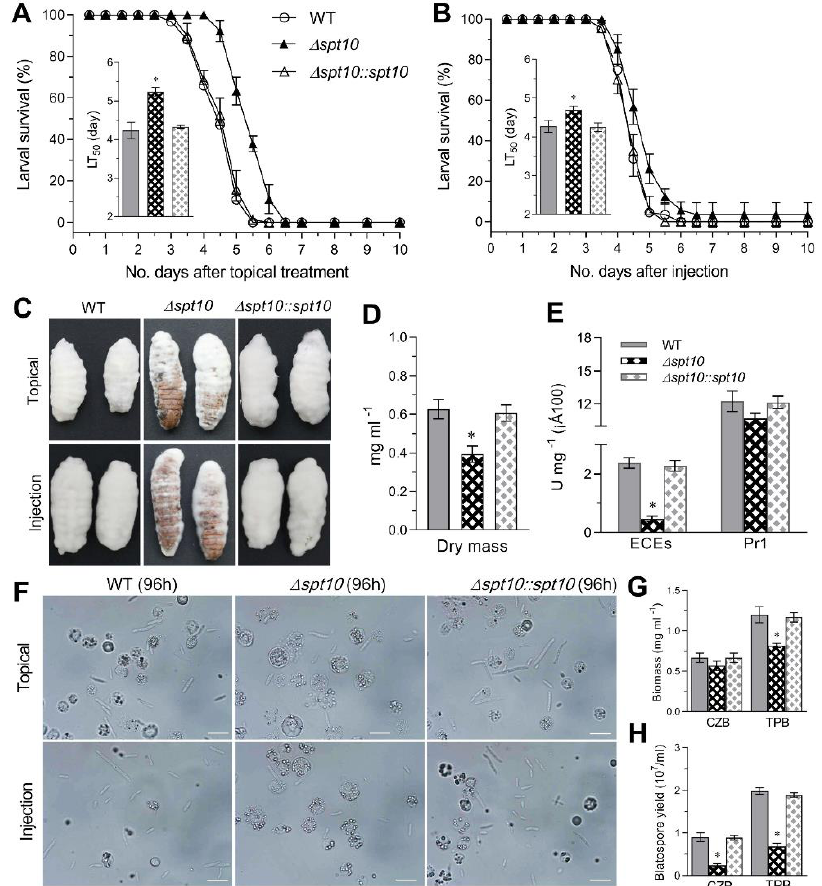
Figure 5. Impact of Spt10 deletion on virulence and virulence-related properties in B. bassiana . ( A , B ) Survival trends and LT 50 estimates of G. mellonella larvae after topical application of a 10 7 conidia ml –1 suspension for normal cuticle infection and intrahemocoel injection of 500 conidia per larva for cuticle bypassing infection, respectively. ( C ) Images for fungal outgrowths on the surfaces of cadavers 4 days post-death. ( D , E ) Biomass levels and total activities of extracellular enzymes (ECEs) and Pr1 proteases quantified from the 3-day-old cultures in CZB-BSA, which contained 0.5% BSA as the sole nitrogen source for enzyme induction and 10 5 conidia ml –1 for culture initiation. ( F ) Microscopic images (scale: 20 μm) for the hyphal bodies formed in the hemolymph samples of G. mellonella larvae 72 h post-topical treatment or post-injection. Spherical or subspherical cells represent host hemocytes. ( G , H ) Biomass levels and blastospore yields (dimorphic transition rates) quantified respectively from the 3-day-old submerged cultures of a10 6 conidia ml –1 suspension grown in CZB and TPB at 25 ◦ C. Asterisked bar in each three-bar group differs significantly from those unmarked (Tukey's HSD, * indicates p < 0.05). Error bars: SD from three replicates.